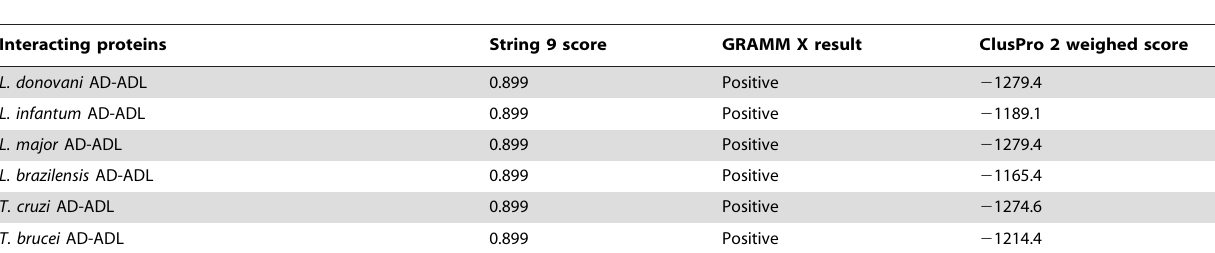
Table 4. Showing AD-ADL interaction in trypanosomatids and their respective interaction